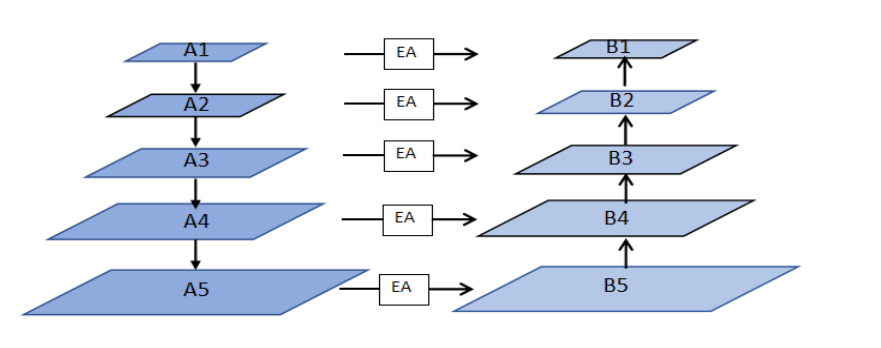
Figure 5. Structure of multi-layer feature